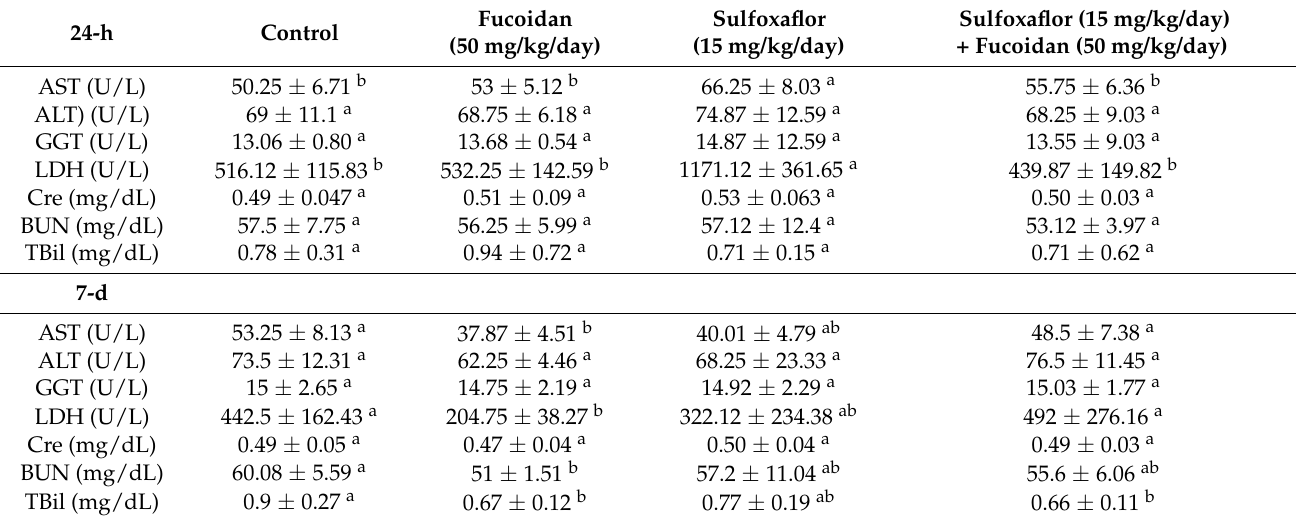
Table 3. Sulfoxaflor had no significant effect on ALT and GGT activity after 24-h and 7-d treatment periods, but AST activity was significantly increased after the 24-h treatment period ( p < 0.05; Table 3) when compared with the control. Similar to the observed changes in AST activity, sulfoxaflor caused significant elevations in LDH activity when compared with the control after the 24-h treatment period ( p < 0.05; Table 3). Sulfoxaflor had no signif- icant effect on Cre, BUN or TBil levels after 24-h or 7-d treatments. Fucoidan significantly decreased serum AST and LDH activities and BUN levels when compared with the control after the 7-d treatment period in the current study ( p < 0.05; Table 3). Fucoidan treatment normalized sulfoxaflor-induced serum AST and LDH activities at the 24-h treatment period ( p < 0.05; Table 3). Sulfoxaflor + fucoidan treatment also significantly decreased TBil levels when compared with the control during the 7-d treatment period ( p < 0.05; Table 3). Table 3. Effects of sulfoxaflor and fucoidan on biochemical parameters in serum of mice at 24-h and 7-d treatment